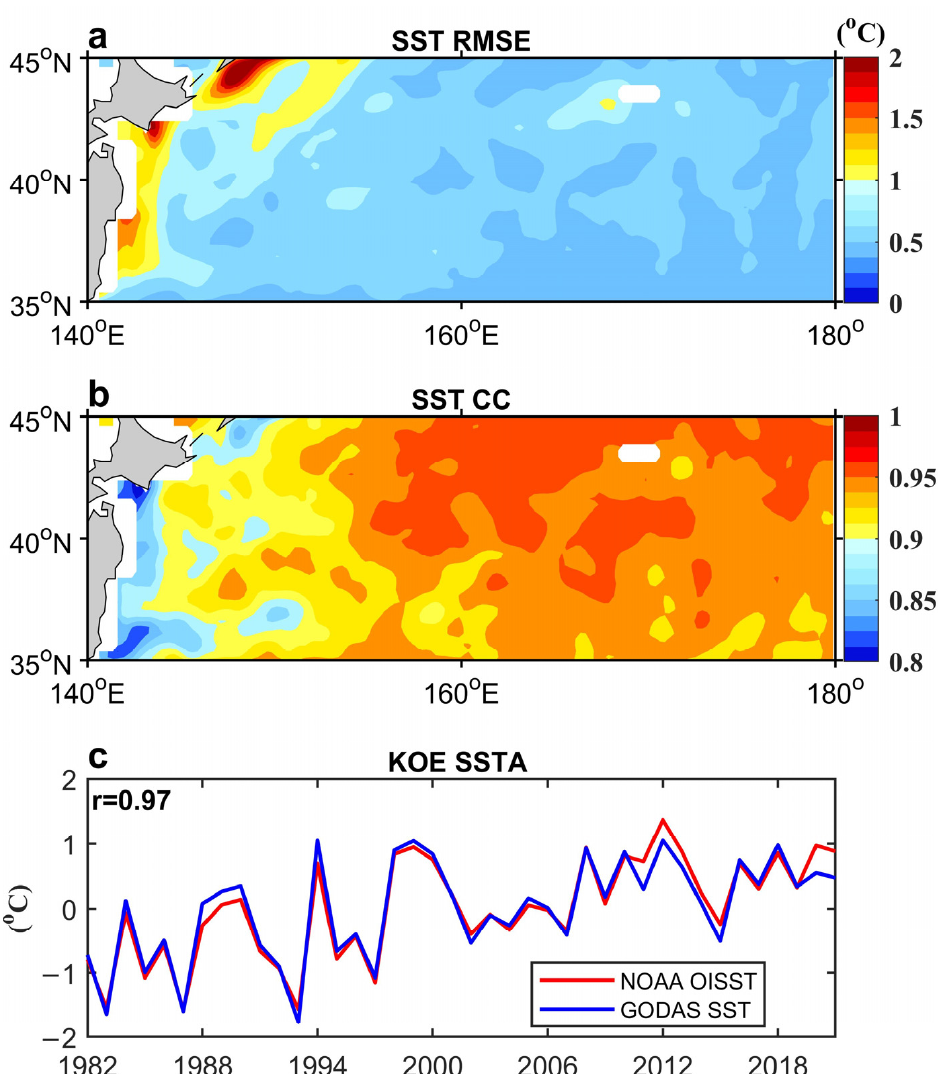
Figure 2. ( a ) The Root Mean Square Error and ( b ) Correlation coefficient of JAS daily SST in the KOE region between GODAS SST and OISST. ( c ) Time series of JAS-averaged surface temperature anomaly (GODAS, blue line) and satellite SSTA (OISST, red line), and their correlation coefficient in the KOE. The pentad 1° × 0.33° GODAS SST grid is interpolated onto the daily 0.25° × 0.25° OISST grid.